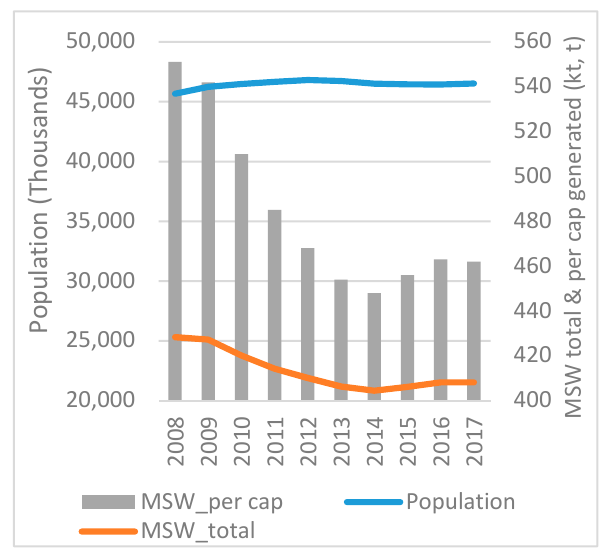
Figure 17. Population and MSW production in Spain 2008–2017 (European Statistics 2019a, 2019c).